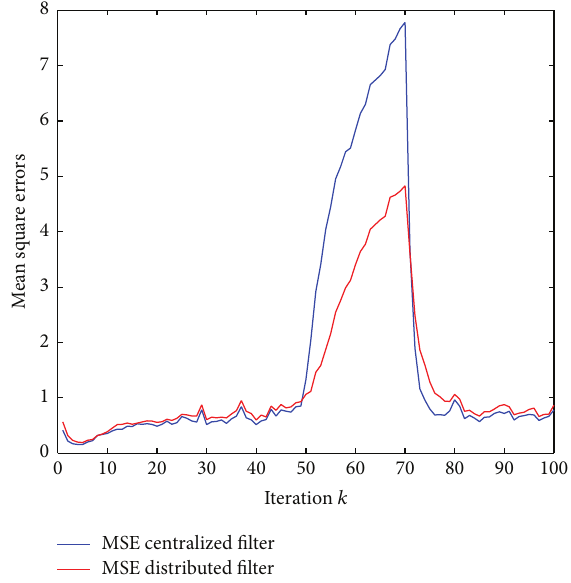
Figure 2: Centralized and distributed filtering mean square errors.